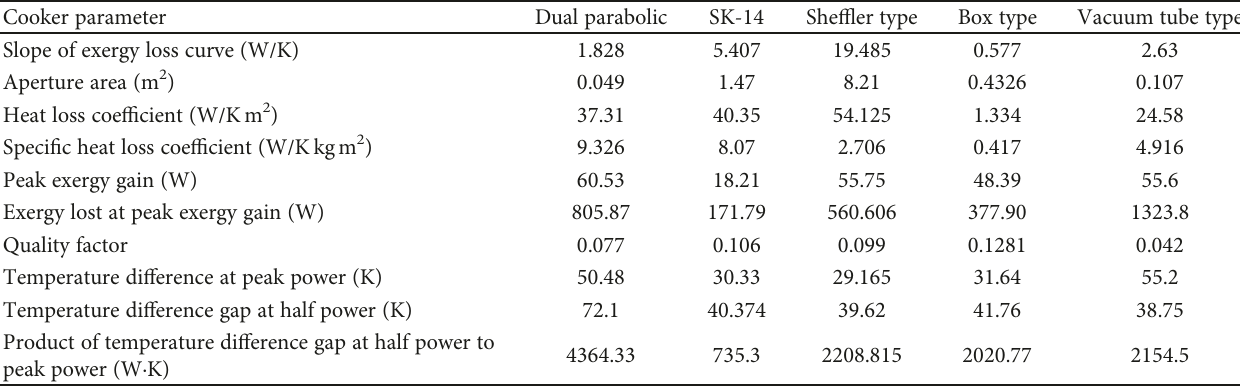
Table 4: Various exergy-based performance measuring parameters for three types of solar cookers. Cooker